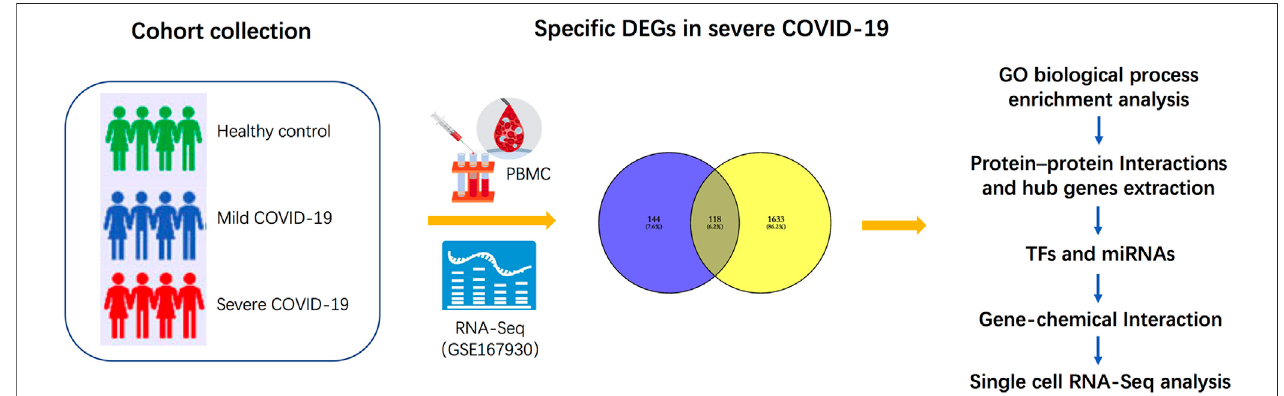
FIGURE 1 | Schematic illustration of the overall general work fl ow of this